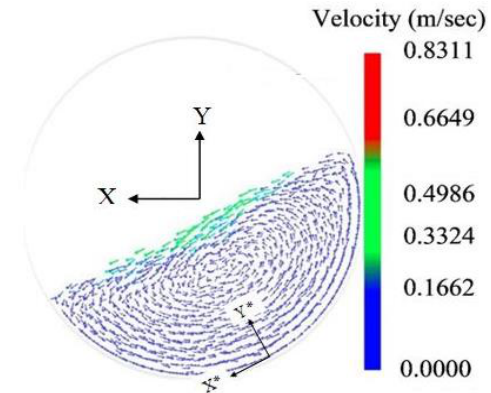
Fig. 3. Velocity distribution of particles on the cross section of the drum at L = 425 mm for  = 10 o .